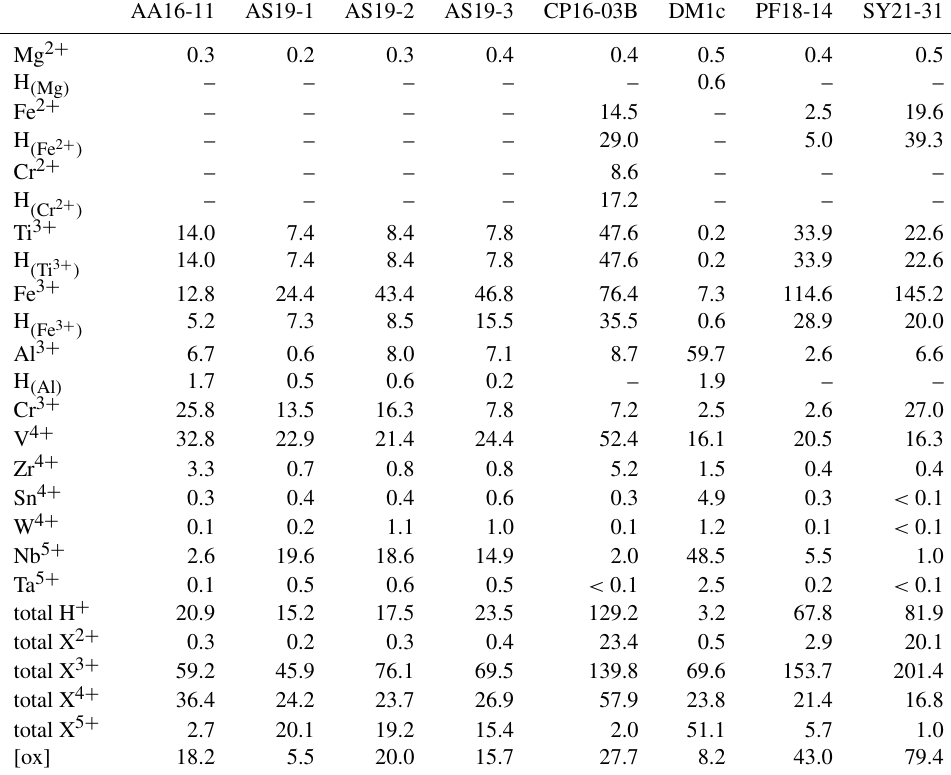
Table 5. Trace element and related H + data (µmolg − 1 rt ). [ox] – oxygen vacancies.